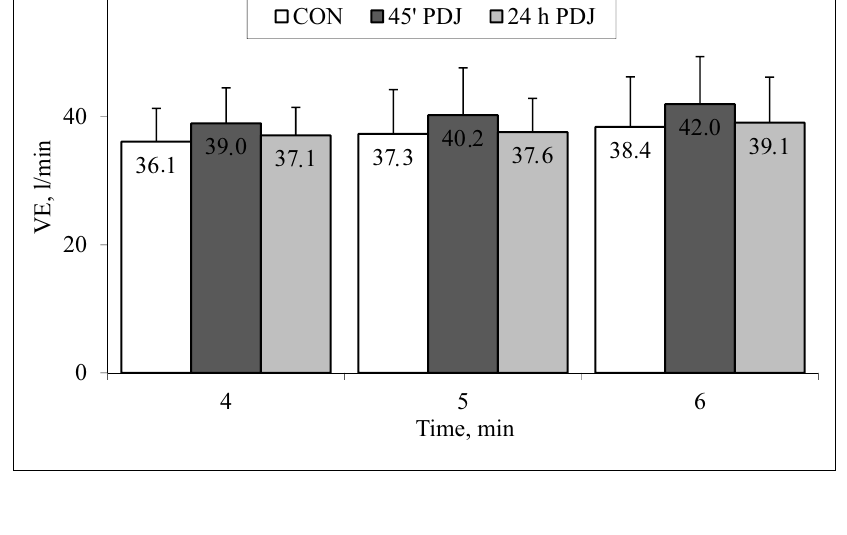
Figure 3. The correlation between changes (from control